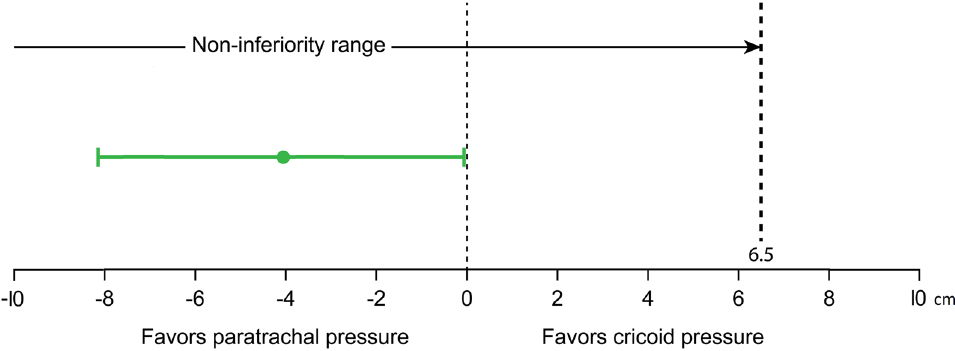
Figure 2. Difference in intubation time between paratracheal pressure group and cricoid pressure group. The green dot and plot indicate the mean difference and 95% CI. The noninferiority margin was set at 6.5